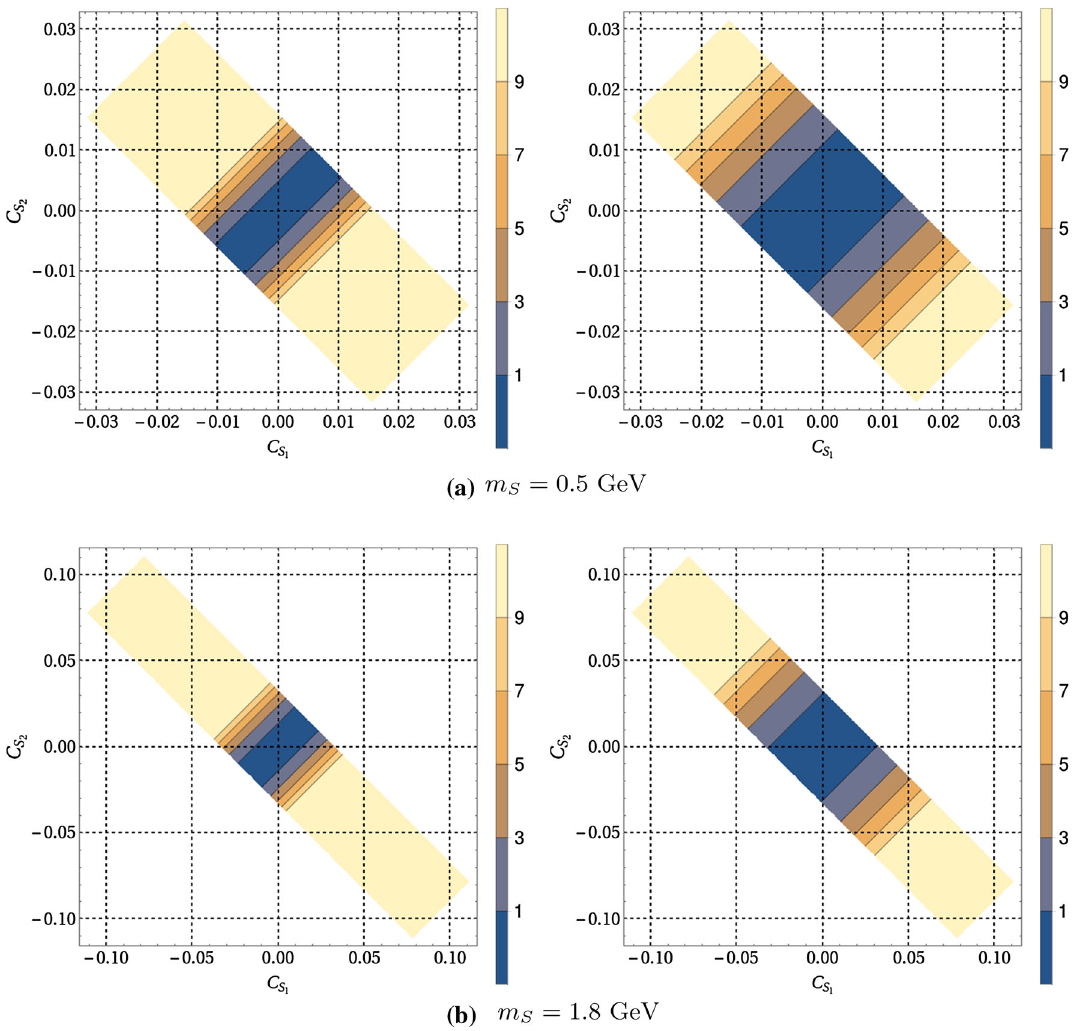
Fig. 9 The contours from the measurement of F (cid:11)